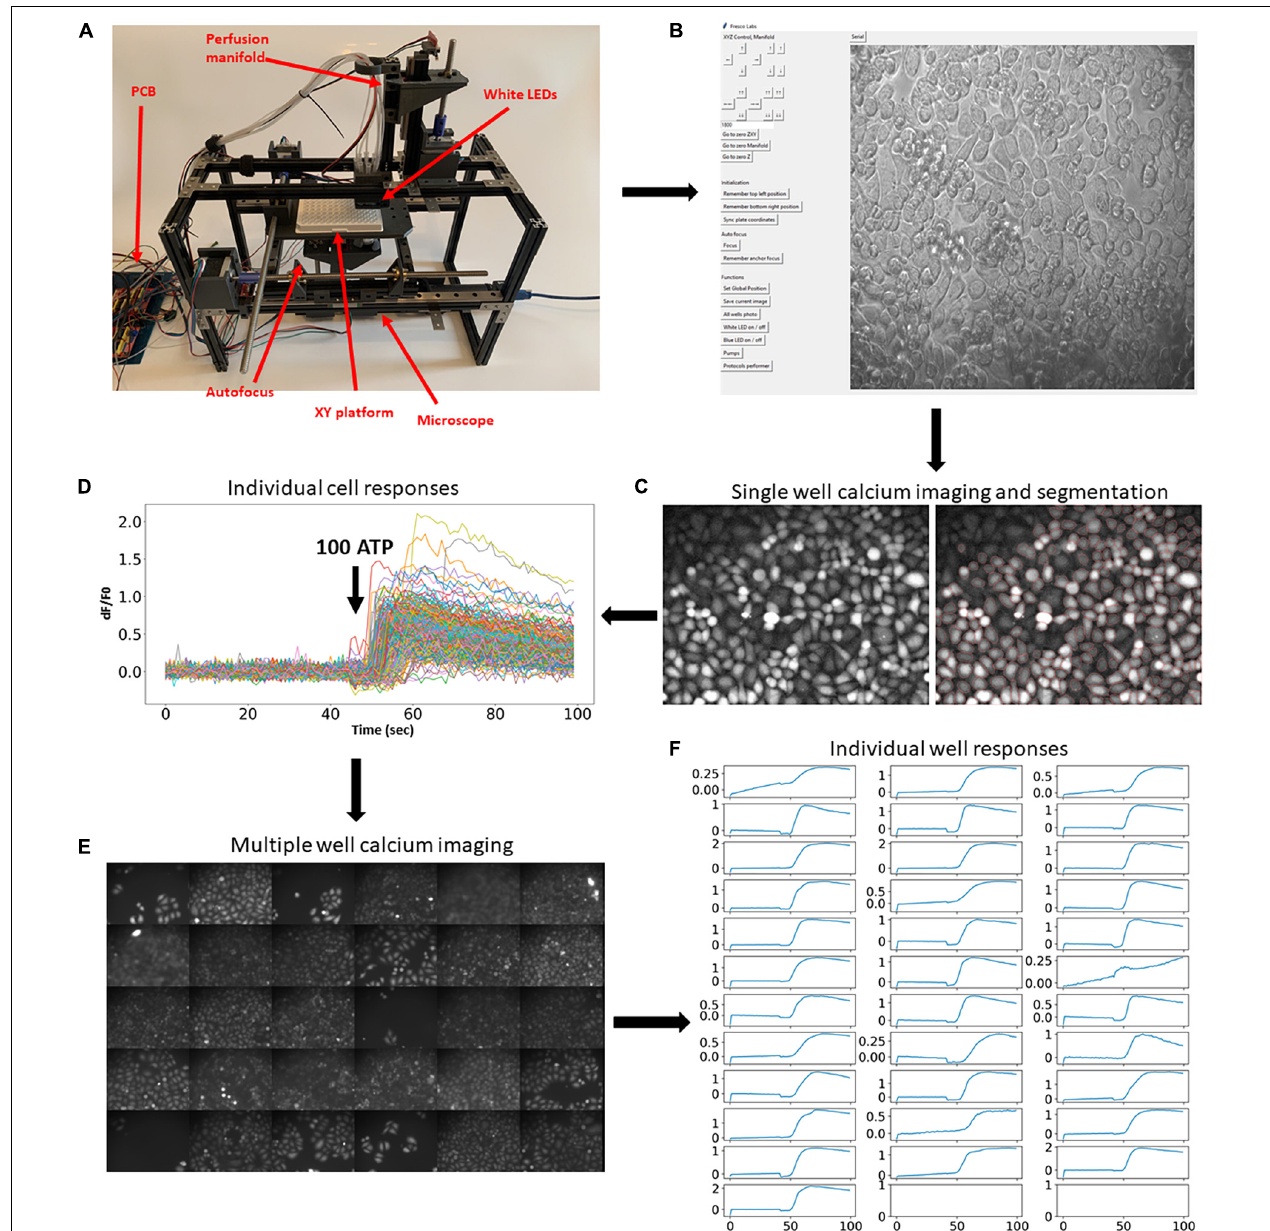
FIGURE 1 | Implementation of the developed platform and its applicability in imaging fluorescent reporters. (A) The developed hardware and the circuit board. The key modules are assigned in red. (B) Hardware operating software. Top buttons operate movement of the multiwell plate, perfusion manifold, and the focusing system. Middle set of buttons drive movement of all motors to zero position. Bottom buttons operate the camera, white and blue LEDs, and pumps, and run selected protocols. (C,D) Example of a single calcium imaging experiment. Cells were automatically labeled with Fluo4-AM calcium dye and imaged before and after application of 100 µ m ATP. Right graph shows cell segmentation using Cellpose algorithm (cell borders are highlighted in red). (E,F) The same calcium imaging experiment was repeated 30 times and average responses in multiple cells in each individual well were calculated and shown in panel (E) . Application of 100 µ m ATP robustly evoked elevation of calcium concentrations in all wells. Scale bars in panels (C,E) are 100 µ m.